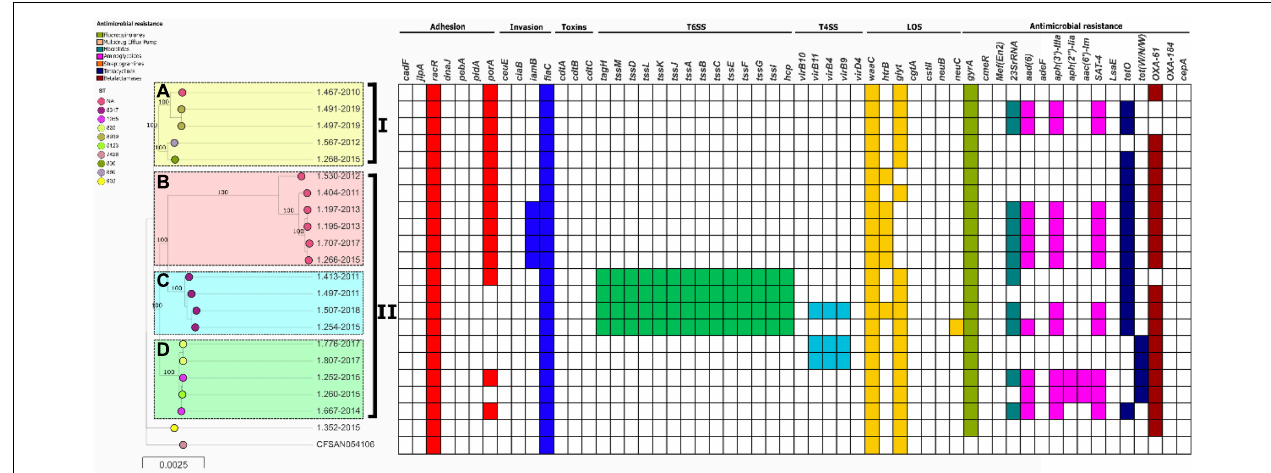
FIGURE 3 | Phylogeny of C. coli ( n = 21) constructed by the maximum likelihood using strain CFSAN054106 as reference. The strains are represented by circles connected by branches proportional to the phylogenetic distance. The code of each strain is indicated as a label parallel to the corresponding circles. The genotypes (ST) among the studied population are denoted by different colors. The clades are denoted by the numbers I and II. The HierBAPS populations lineages found are highlighted by colored boxes and named A–D. The presence of virulence genes is denoted by blocks in color based on six categories: Adhesion (Red), Invasion (Blue), Toxins (Purple), T6SS (Green), T4SS (Light Blue), and LOS (Yellow). The presence of resistance genes is denoted by blocks in color according to the spectrum of action: Fluoroquinolones (green), Multidrug Efflux pump (Red), Macrolides (Blue), Aminoglycosides (Pink), Streptogramins (Orange), Tetracycline (Blue), and Beta-Lactamases (Brown). The names of detected genes are indicated above the blocks. The absence of a gene is indicated by a white block.